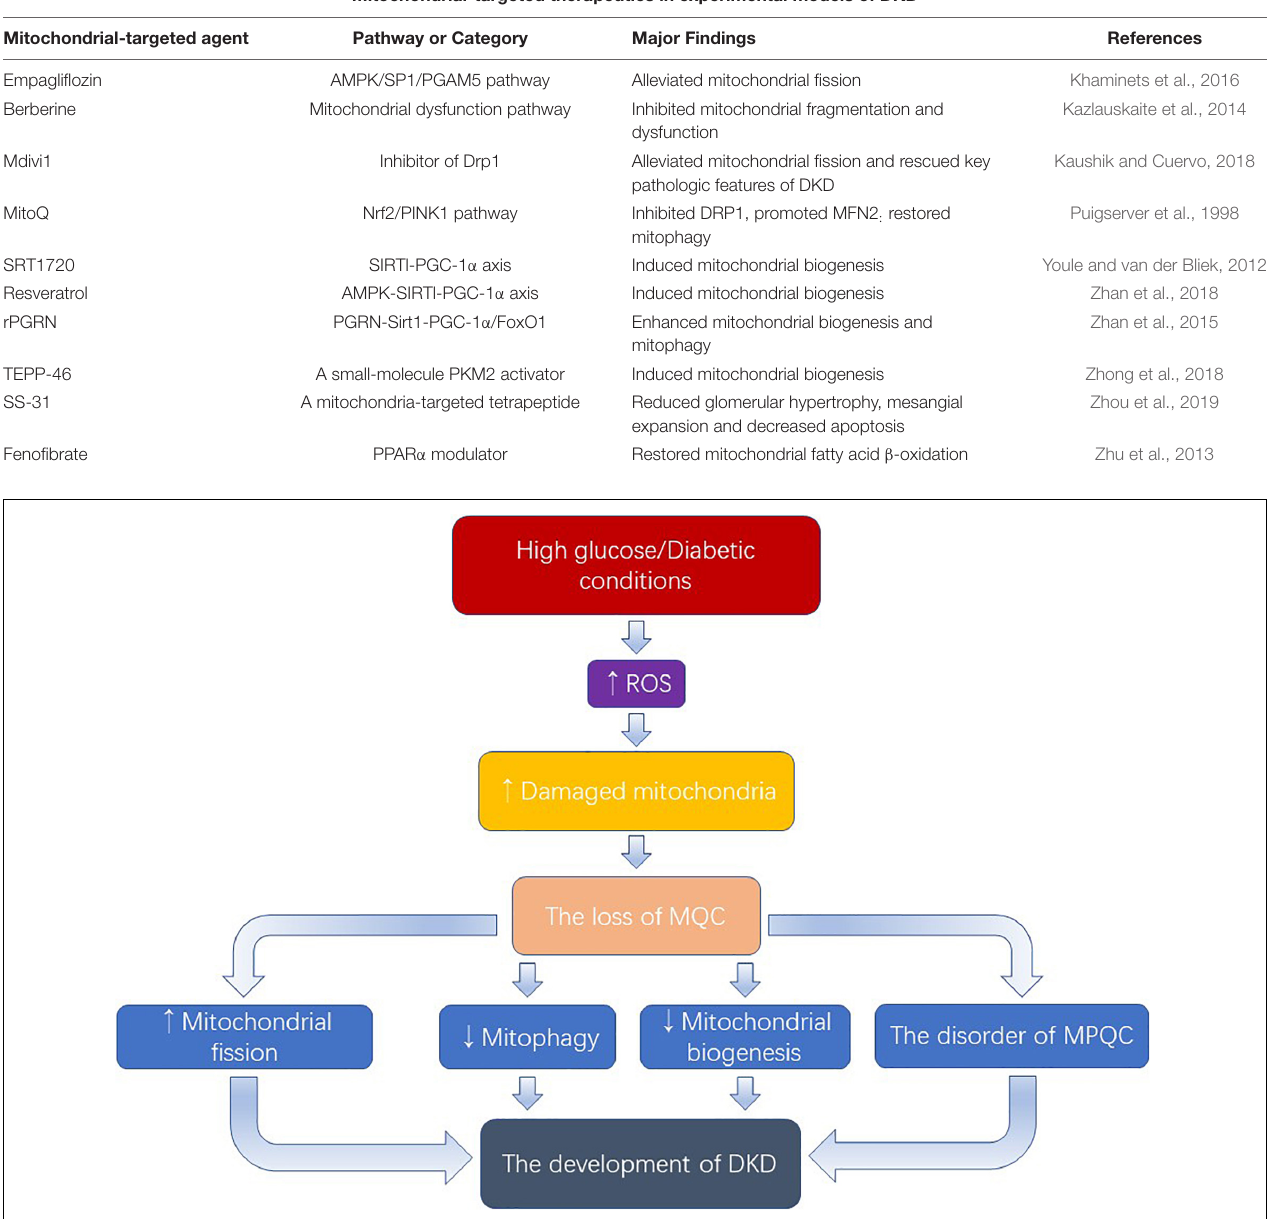
TABLE 1 | Mitochondrial-targeted therapeutics in experimental models of DKD.